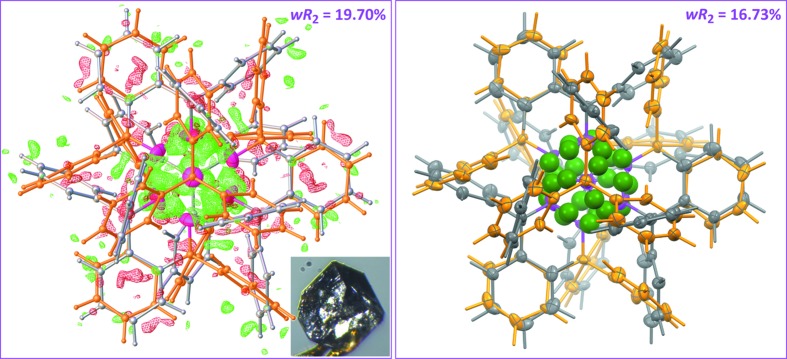
(Left) Difference electron-density map computed using low-temperature data, after refining the full disordered model but omitting hy­droxy H atoms. Grey mol­ecules correspond to the main part A/B (occupancy 0.74) and gold mol­ecules to the minor part C/D (occupancy 0.26); hy­droxy O atoms are represented with magenta ellipsoids. Two tetra­mers are displayed in a projection along the threefold crystallographic axis. The difference map is plotted at the 0.33 e Å−3 level (green wire for Δρ > 0 and red wire for Δρ < 0; Dolomanov et al., 2009 ▸). Note how most of the positive residuals are concentrated within the cavity delimited by the eight clustered O atoms. The inset is the crystal used for data collection. Note the triangular face on the top of the crystal, corresponding to the (003) face. (Right) Final model, including 24 disordered hy­droxy H atoms, shown as green spheres with a radius corresponding to 33% of the van der Waals radius. All C and O atoms are displayed with displacement ellipsoids at the 20% probability level (Mercury; Macrae et al., 2008 ▸).